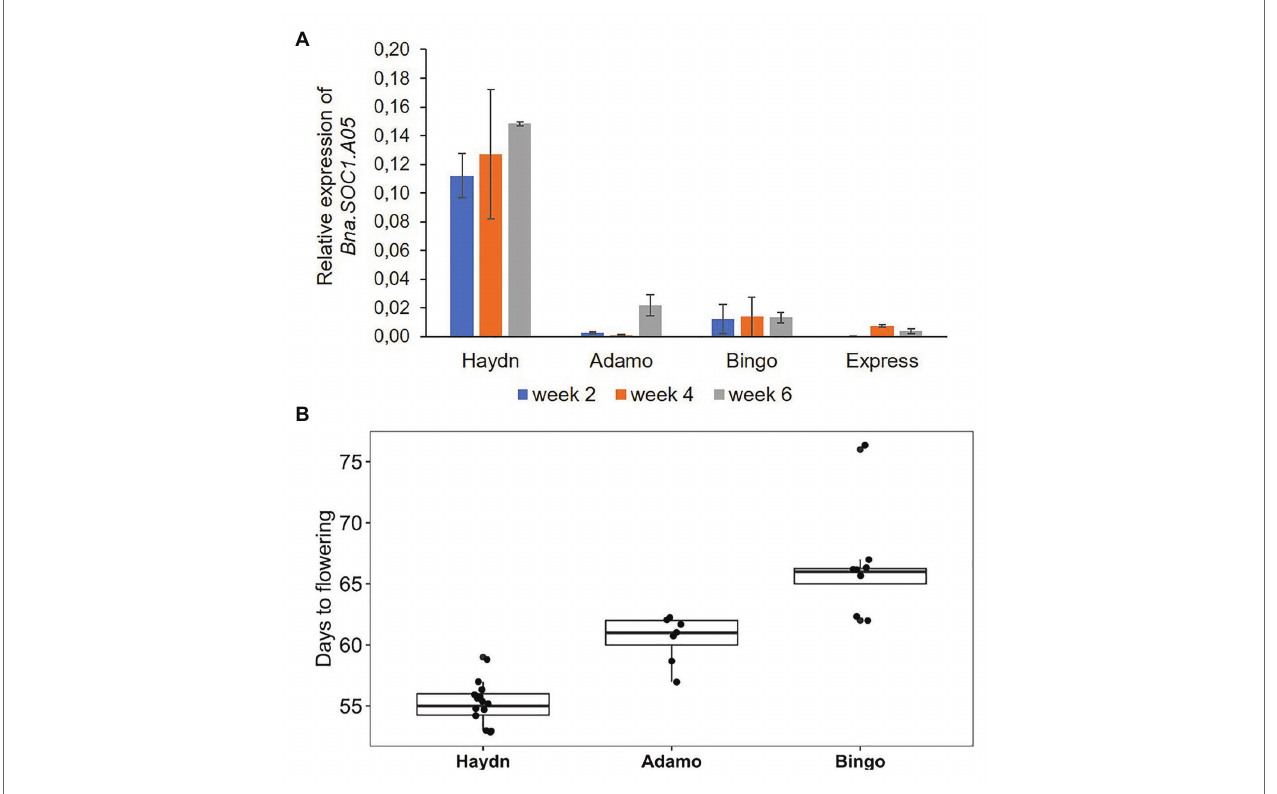
FIGURE 4 | Expression and flowering time variation in different rapeseed accessions. (A) Expression levels of Bna.SOC1.A05 in the apices four different rapeseed accessions, 2, 4, and 6 weeks after sowing. Expression was normalized to Bna.Actin2 . Error bars represent SEM of three biological replicates. (B) Days to flowering determined by scoring the opening of the first flower in three different spring